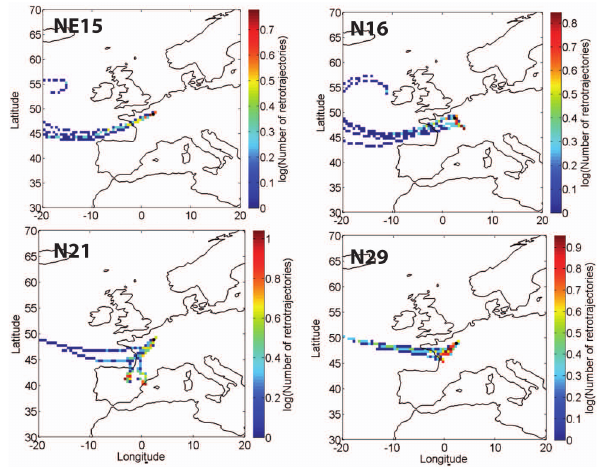
Fig. 1. Air mass backward trajectories calculated using HYSPLIT for 72h. HYSPLIT trajectories are calculated at a height of 700m in the HYSPLIT model. Colour scale is used to indicate the log of the number of back trajectories that pass over a given area (pixel) of 0.5 ◦ × 0.5 ◦